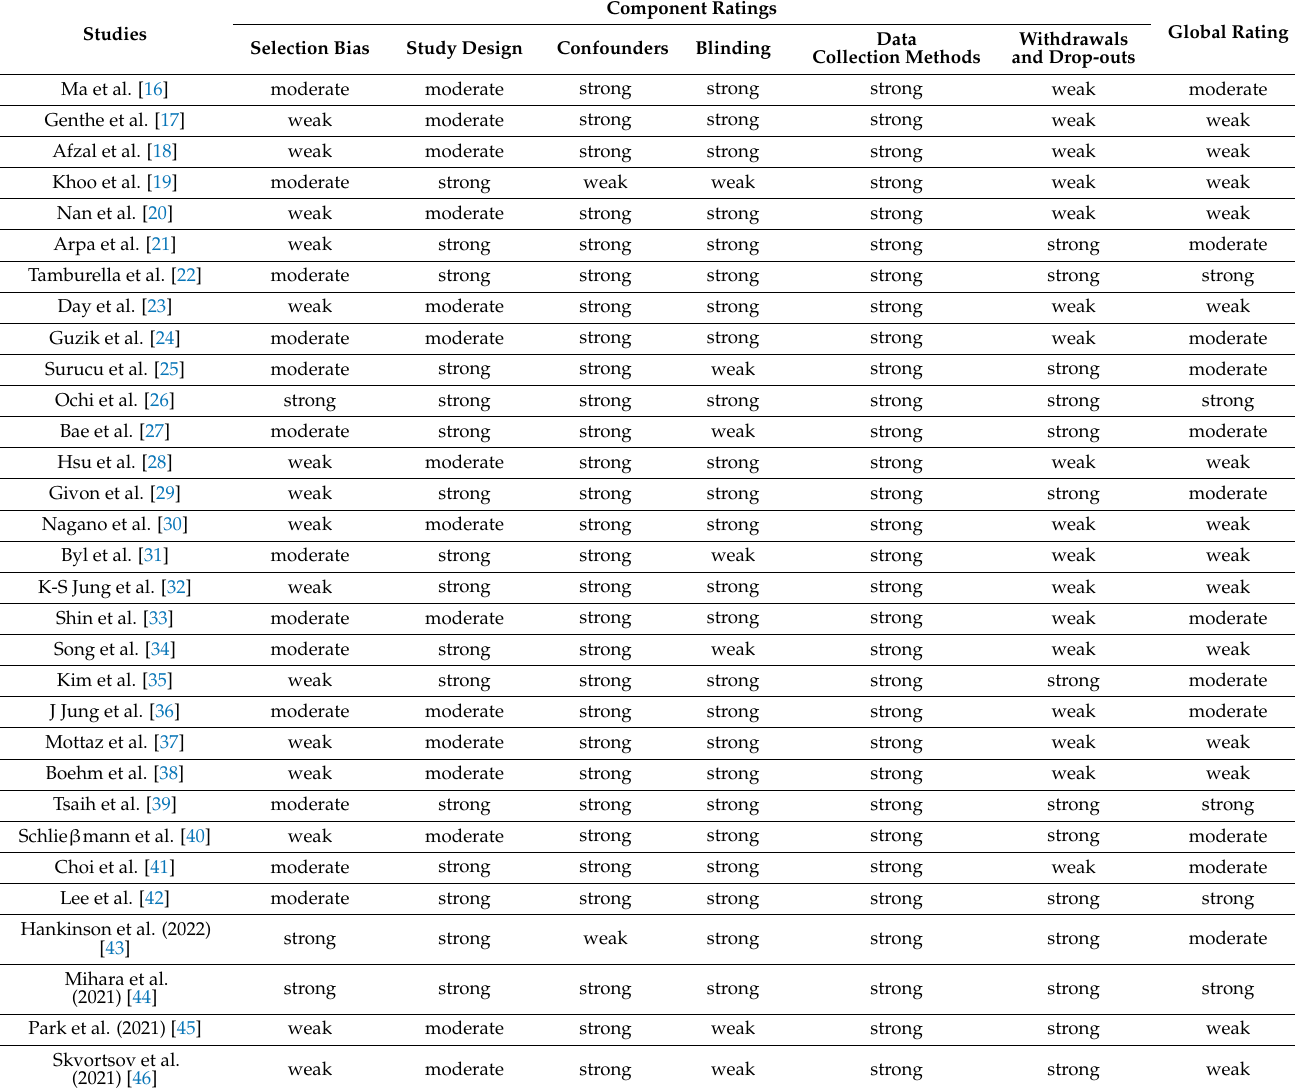
Table 4. Quality assessment results through EPHPP tool for each